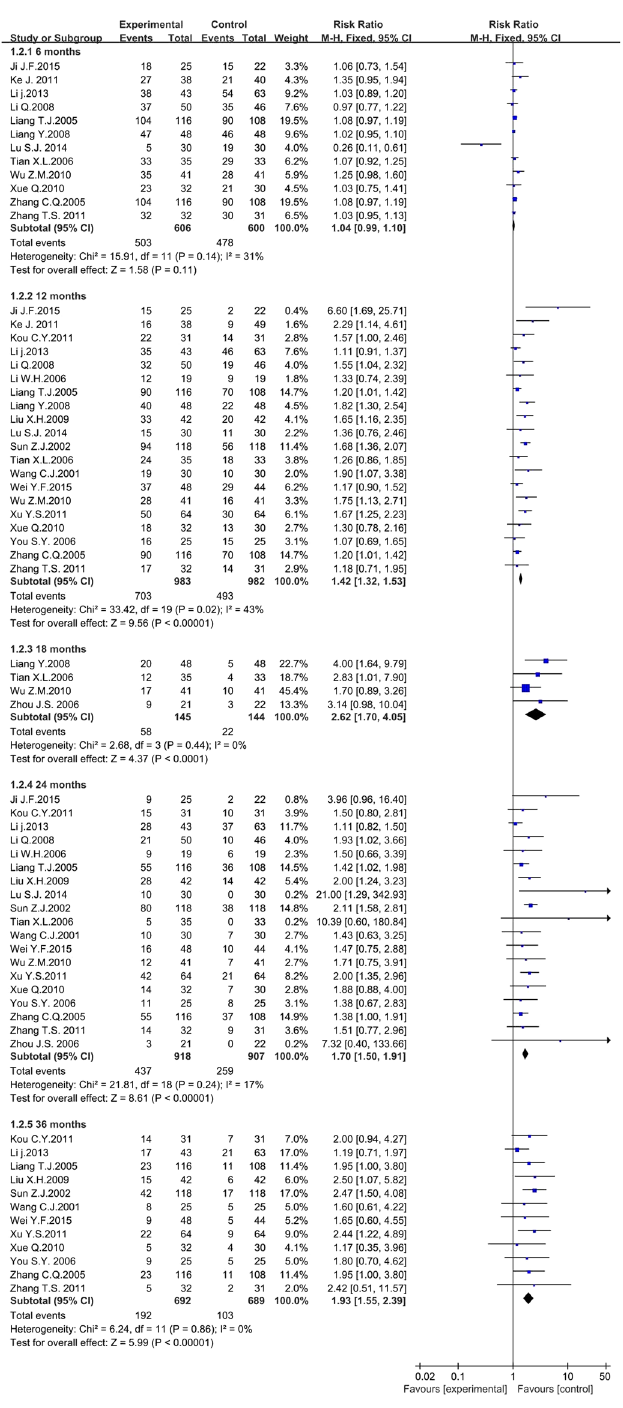
Figure 5. The forest plot of survival time for traditional insect Chinese medicine and the related preparation combined chemotherapy versus chemotherapy alone ( M-H : Mantel-Haenszel estimates; CI : Confidence